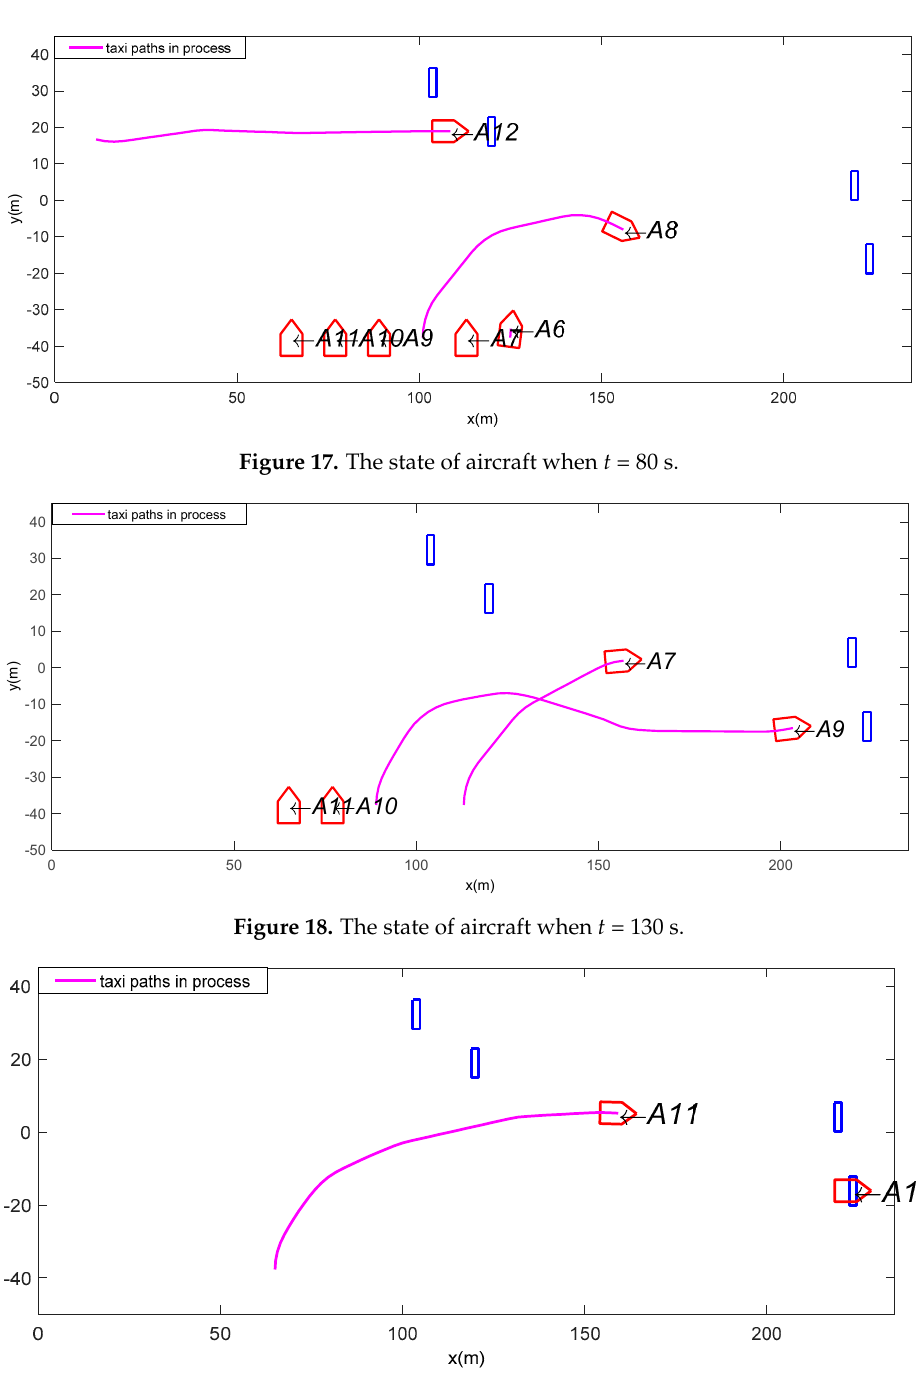
Figure 19. The state of aircraft when t = 180 s.